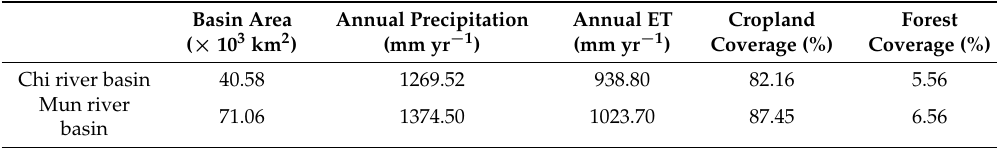
Figure 10. Spatial variation of ( A ) plant transpiration, ( B ) soil evaporation, ( C ) canopy rainfall interception, and ( D ) total ET (mm yr -1 ), in Northeastern Thailand from 2001 to 2015. The boundaries of Chi river basin and Mun river basin are also plotted. Table 5. Statistic information of Chi and Mun river basins.